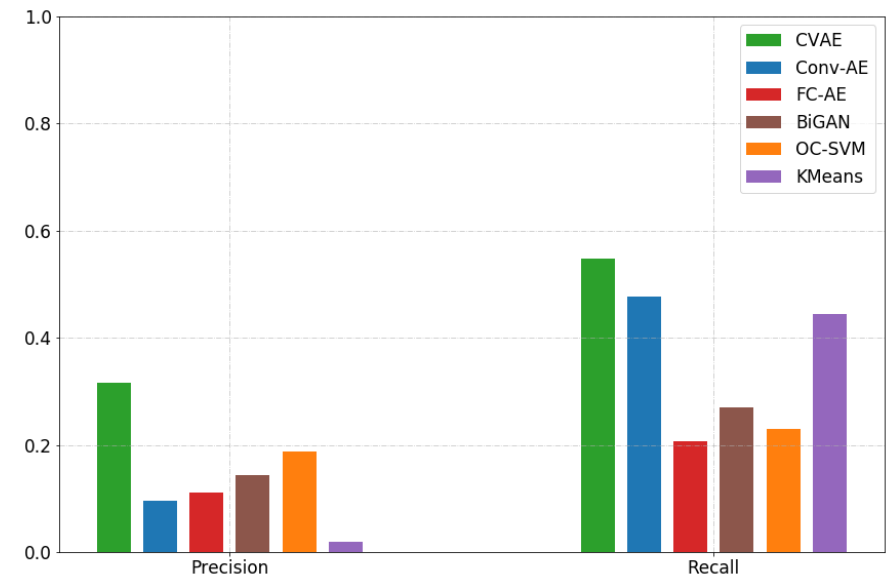
Figure 5. Validating the performance of CVAE on the FOQA data against Conv-AE, FC-AE, BiGAN, OC-SVM, and